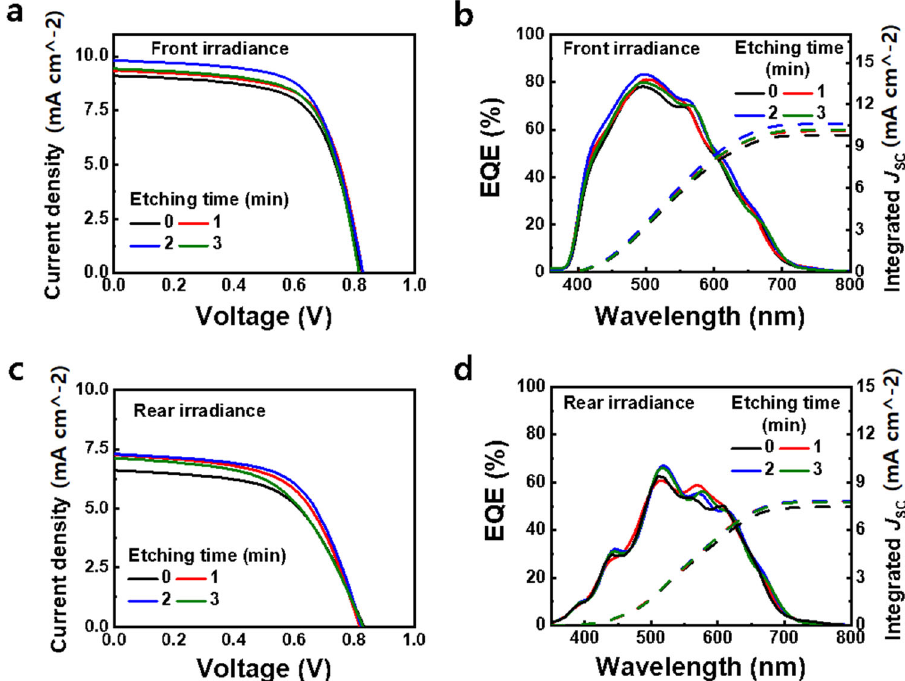
Fig. 4 Flexible TSCs characteristics. Effects of etching time on a , c current density – voltage ( J – V ) curves and b , d external quantum ef fi ciency (EQE) spectra and integrated short-circuit current densities ( J SC ) of transparent solar cells (TSCs) fabricated using T-CPI fi lms: a , b front-side and c , d rear-side